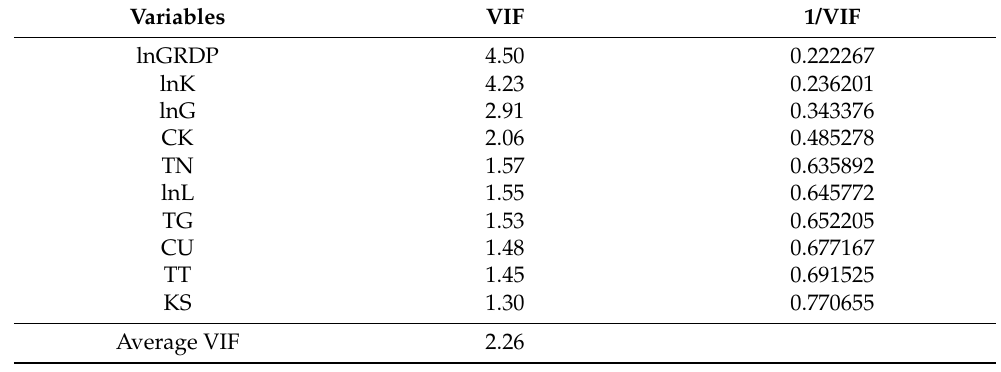
Table 3. Test multicollinearity of independent variables.